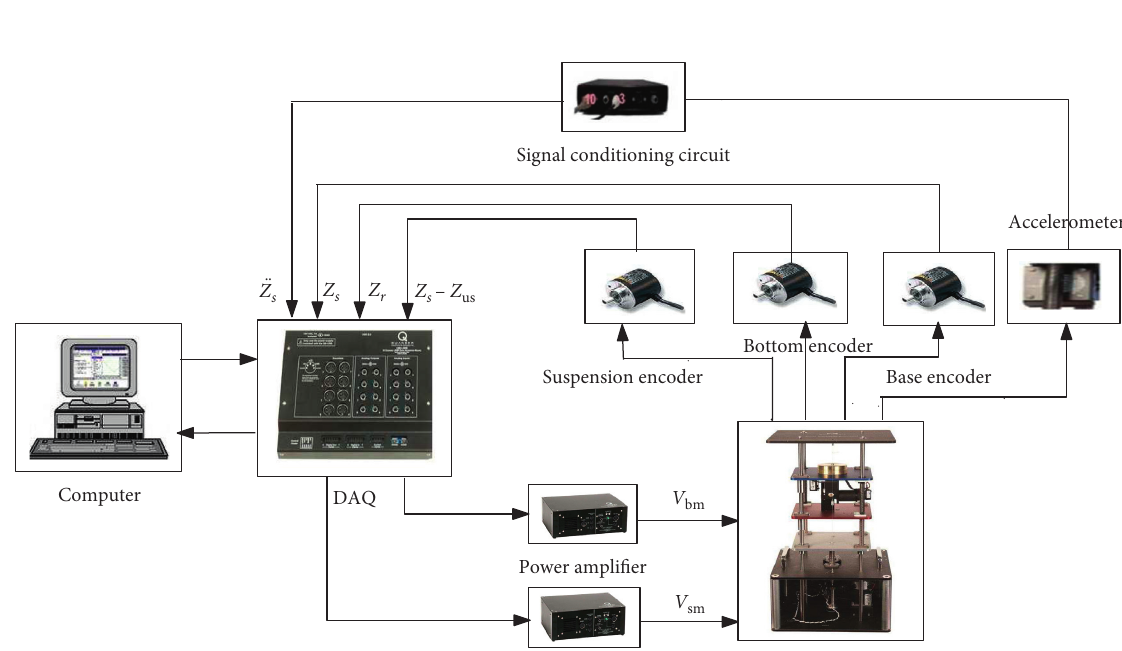
Figure 7: Experimental